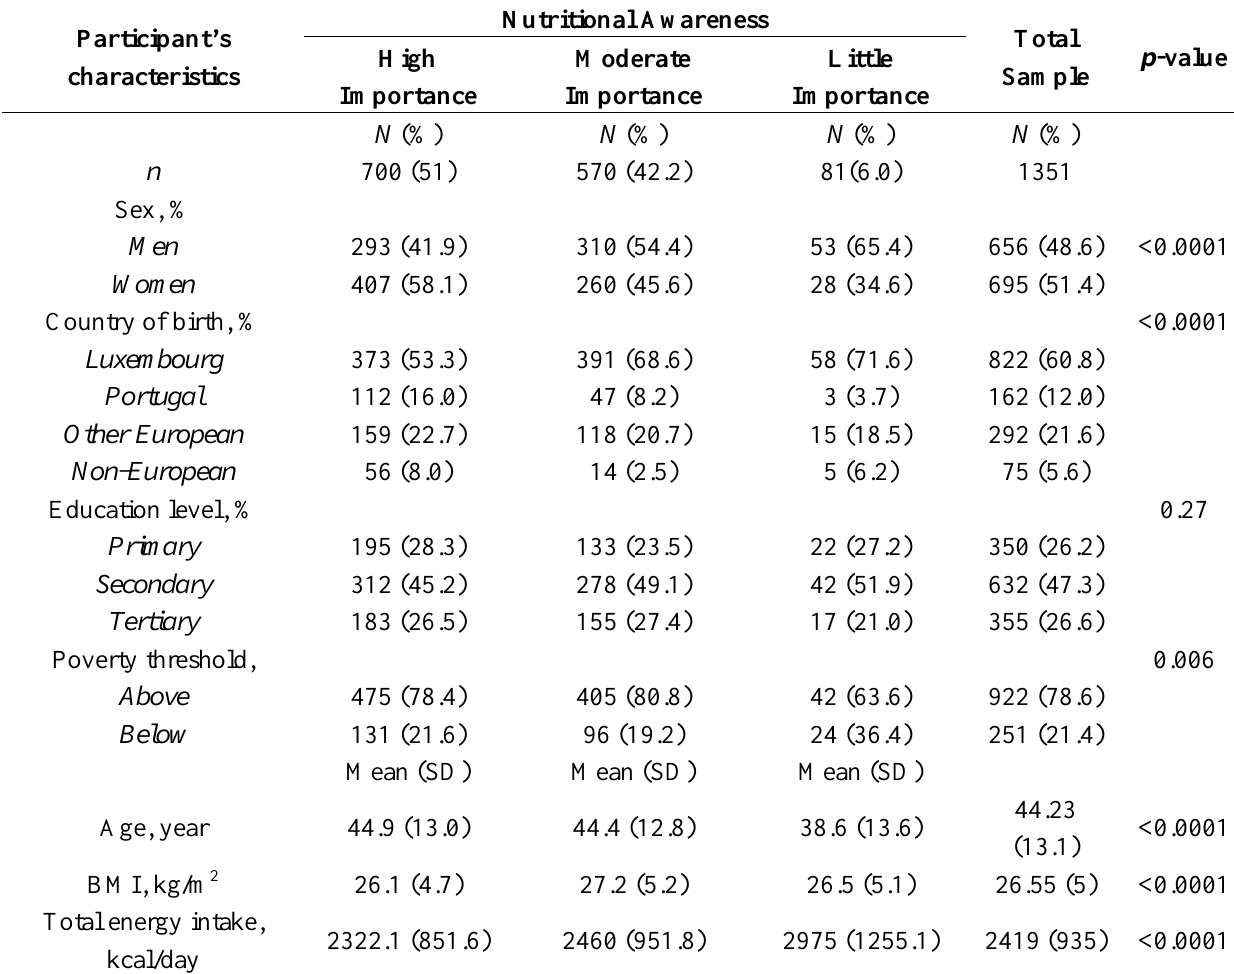
Table 1. Description of participants’ characteristics by nutrition awareness, ORISCAV-LUX study,